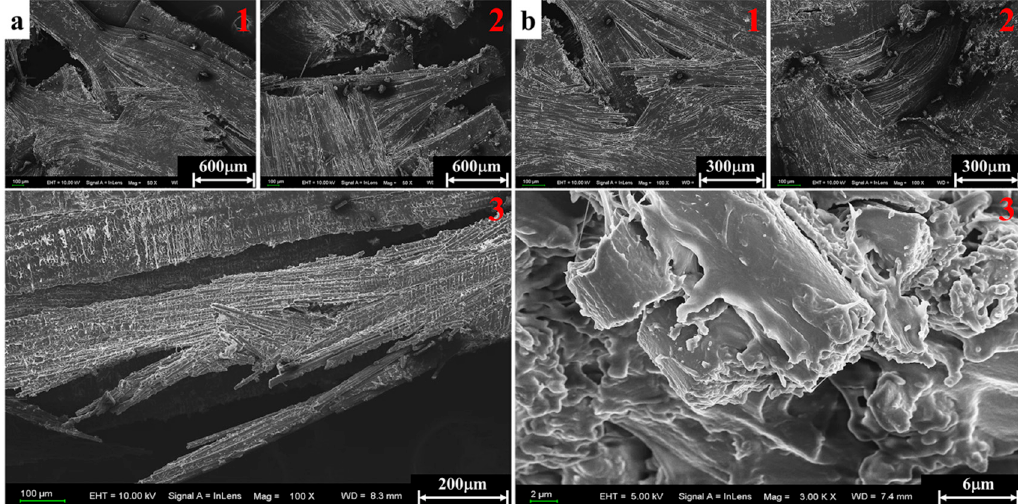
Figure 12. Fibers kink and crush in residual debris at a strain rate of 6848/s. ( a ) Fiber kink. ( b ) Fiber crush.